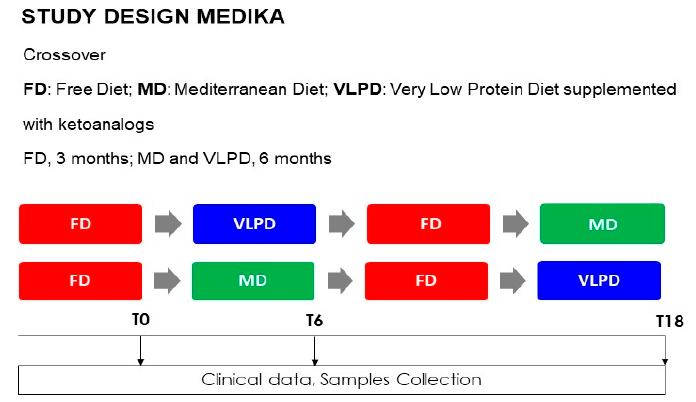
Figure 1. Study design: FD = free diet, VLPD = very low protein diet, MD = Mediterranean diet. Table 1. Diet